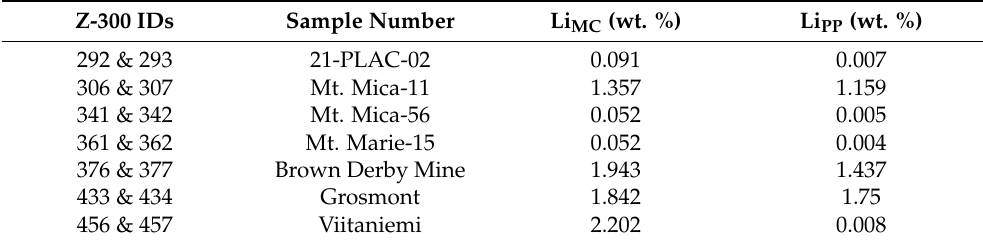
Table 4. Li analysis of mica using the mica (MC) and pegmatite powder (PP)